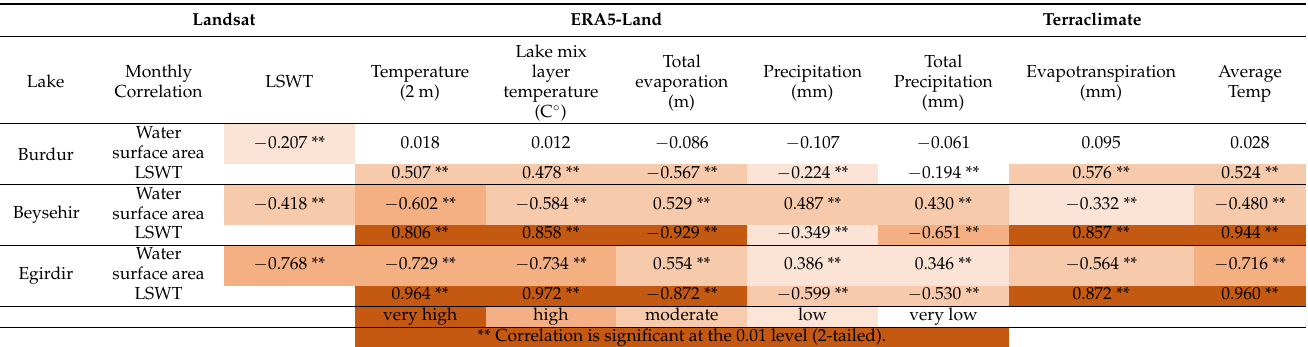
Table 6. The monthly correlation analysis of meteorological parameters with LSWT and water surface